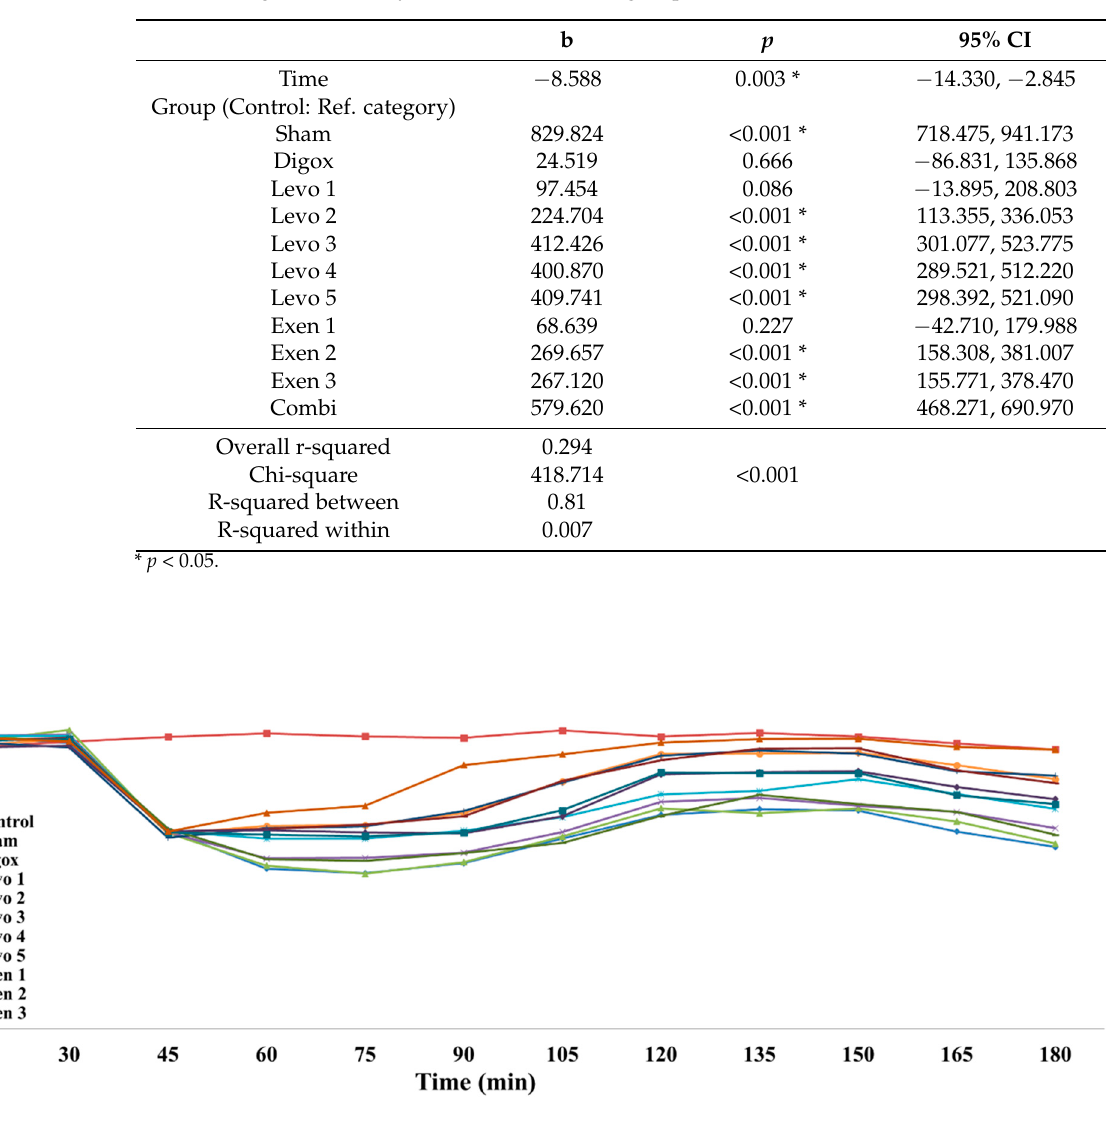
Table 7. Longitudinal analysis for − dP/dt for all groups.